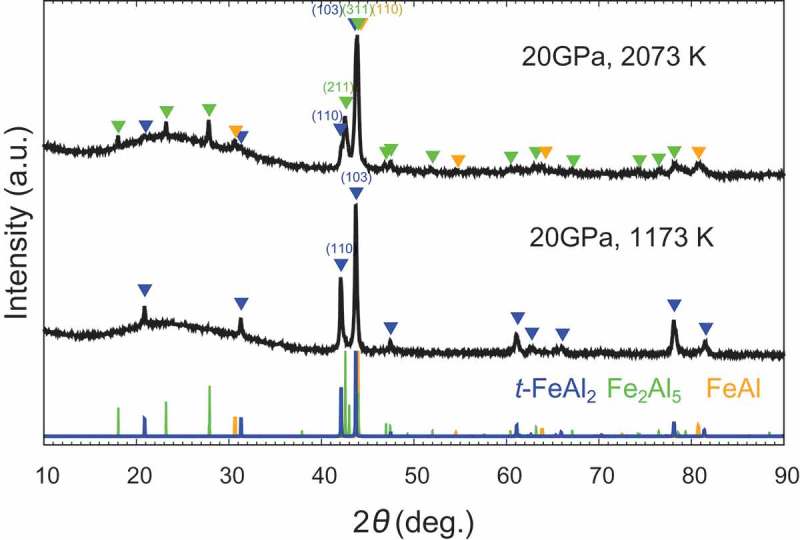
X-ray diffraction patterns with Cu Kα of the sample synthesized at (top) 20 GPa and 2073 K and (bottom) 20 GPa and 1173 K. We succeeded in synthesizing a single-phase t-FeAl2 sample at 20 GPa and 1173 K, whereas most of the t-FeAl2 decomposed into FeAl and Fe2Al5 at 20 GPa and 2073 K.